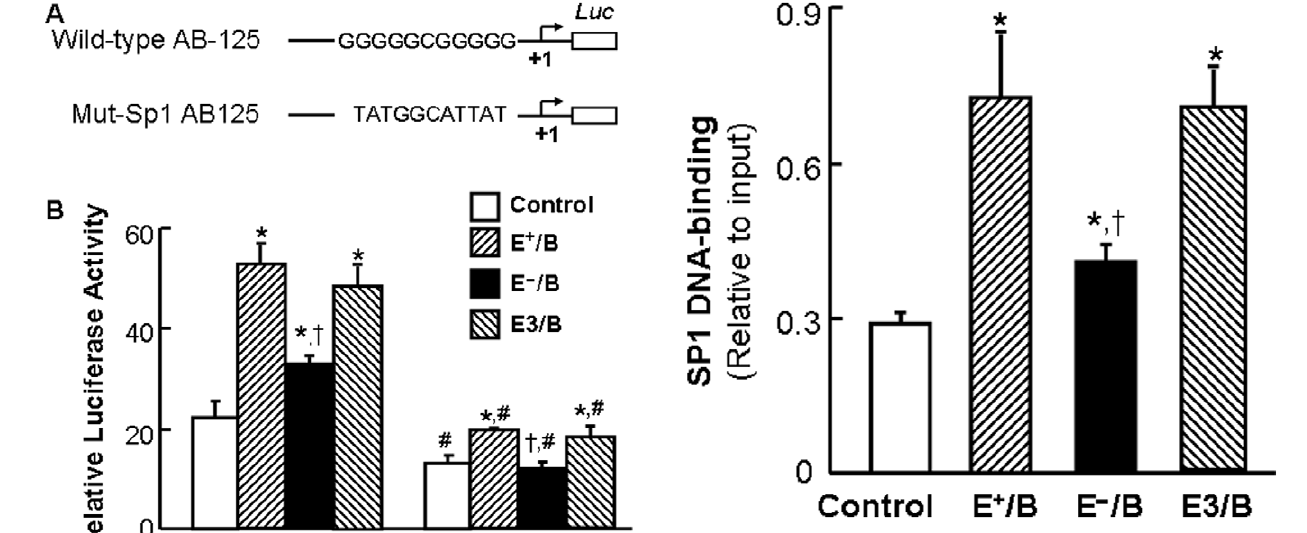
Figure 3. The effect of ApoE on lipoprotein-induced Sp1 DNA- binding activity. Mouse macrophages were treated with 20 m g/ml of wild-type (E + /B), ApoE-free (EIˆ/B) or ApoE3-enriched (E3/B) lipoproteins, or culture medium alone (control) for 4 hrs. The amount of Sp1 bound to the ABCA1 promoter region was determined by ChIP analysis, and expressed as the ratio of input controls. Values represent the mean 6 SEM of 5 separate experiments. * P , 0.05 compared to control, { P , 0.05 compared to E + /B or E3/B lipoprotein